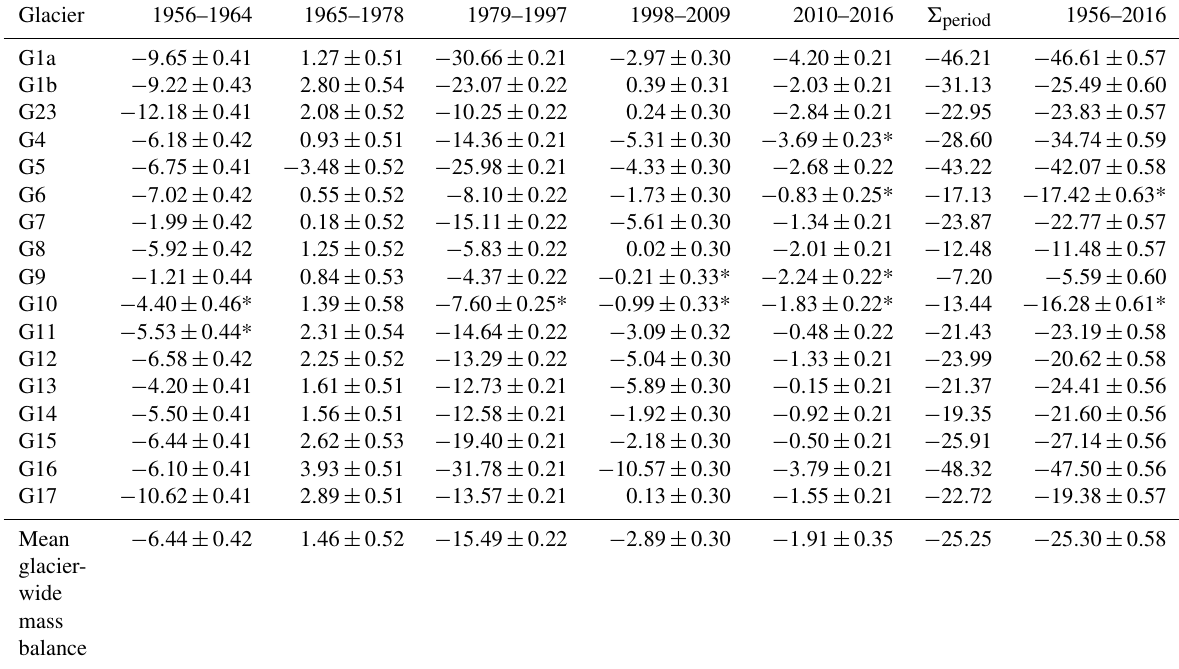
Table 4. Glacier-wide cumulative mass balance in metres water equivalent (mw.e.) observed during the last 6 decades for the 17 glaciers on the Antisana ice cap. When mass losses occur the density conversion value is ρ = 850 ± 60kgm − 3 ; when mass gains occur the density conversion value is ρ = 564 ± 64kgm − 3 . The * symbol indicates periods when more than 40% of information concerning changes in the elevation of the surface area of the glacier was missing. (cid:54) period is the sum of glacier mass balance derived from the five sub-periods.